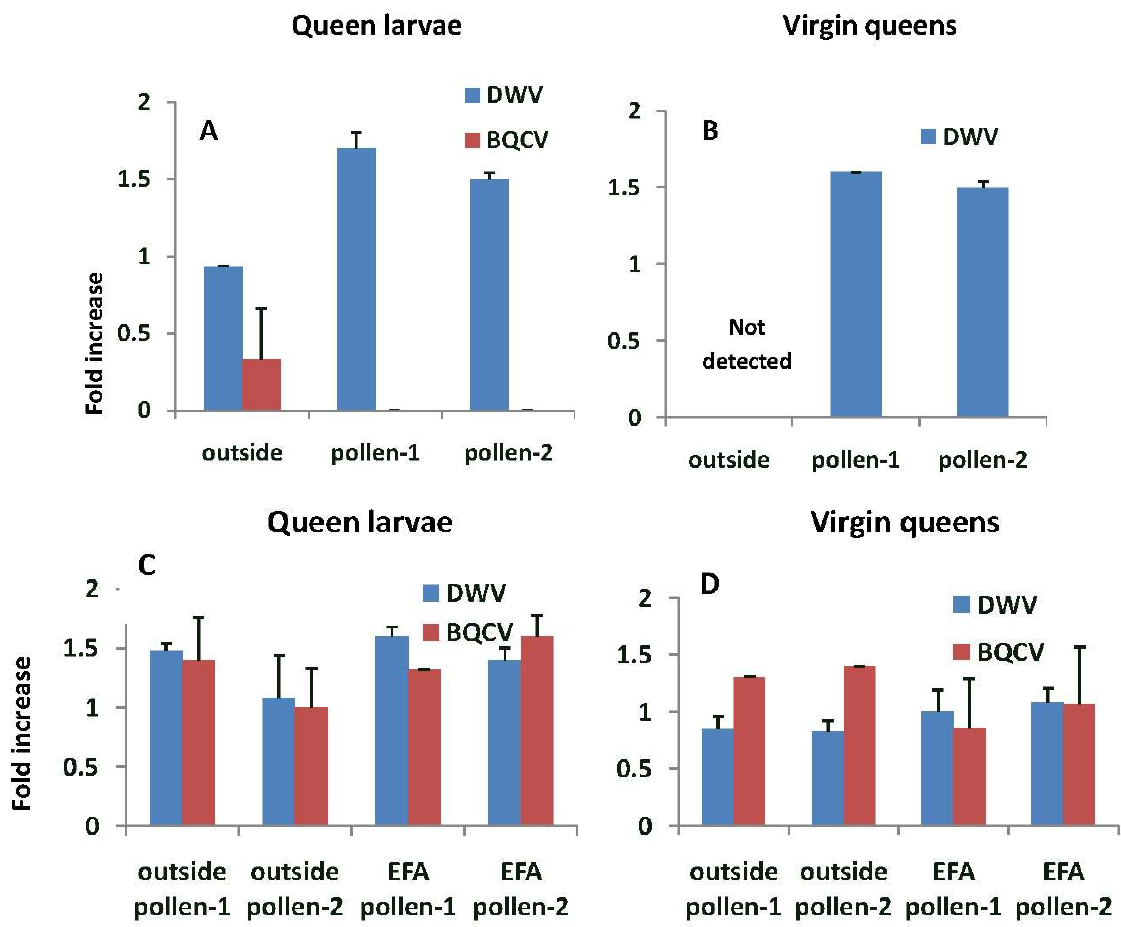
Figure 7. Fold increase in deformed wing virus (DWV) and Black queen cell virus (BQCV) titers relative to the nurse bees sampled while tending queen cells. ( A ) and ( B ) are from queens reared from grafts of larvae from outside colonies and reared in either outside colonies or those in an enclosed flight area fed pollen-1 (chlorpyrifos) or pollen-2 (chlorpyrifos with added Pristine ® ). ( C ) and ( D ) are from larvae grafted from and reared into queens in colonies fed pollen-1 or 2 or reared in outside colonies. Estimates of virus titers were made from 3 queen larvae and 3 virgin queens in each treatment group with the exception of outside larvae that were reared in colonies fed pollen-2 where two virgin queens were analyzed. Estimates of virus titers in nurse bees were based on samples of 9 (cid:177) 15 bees per treatment